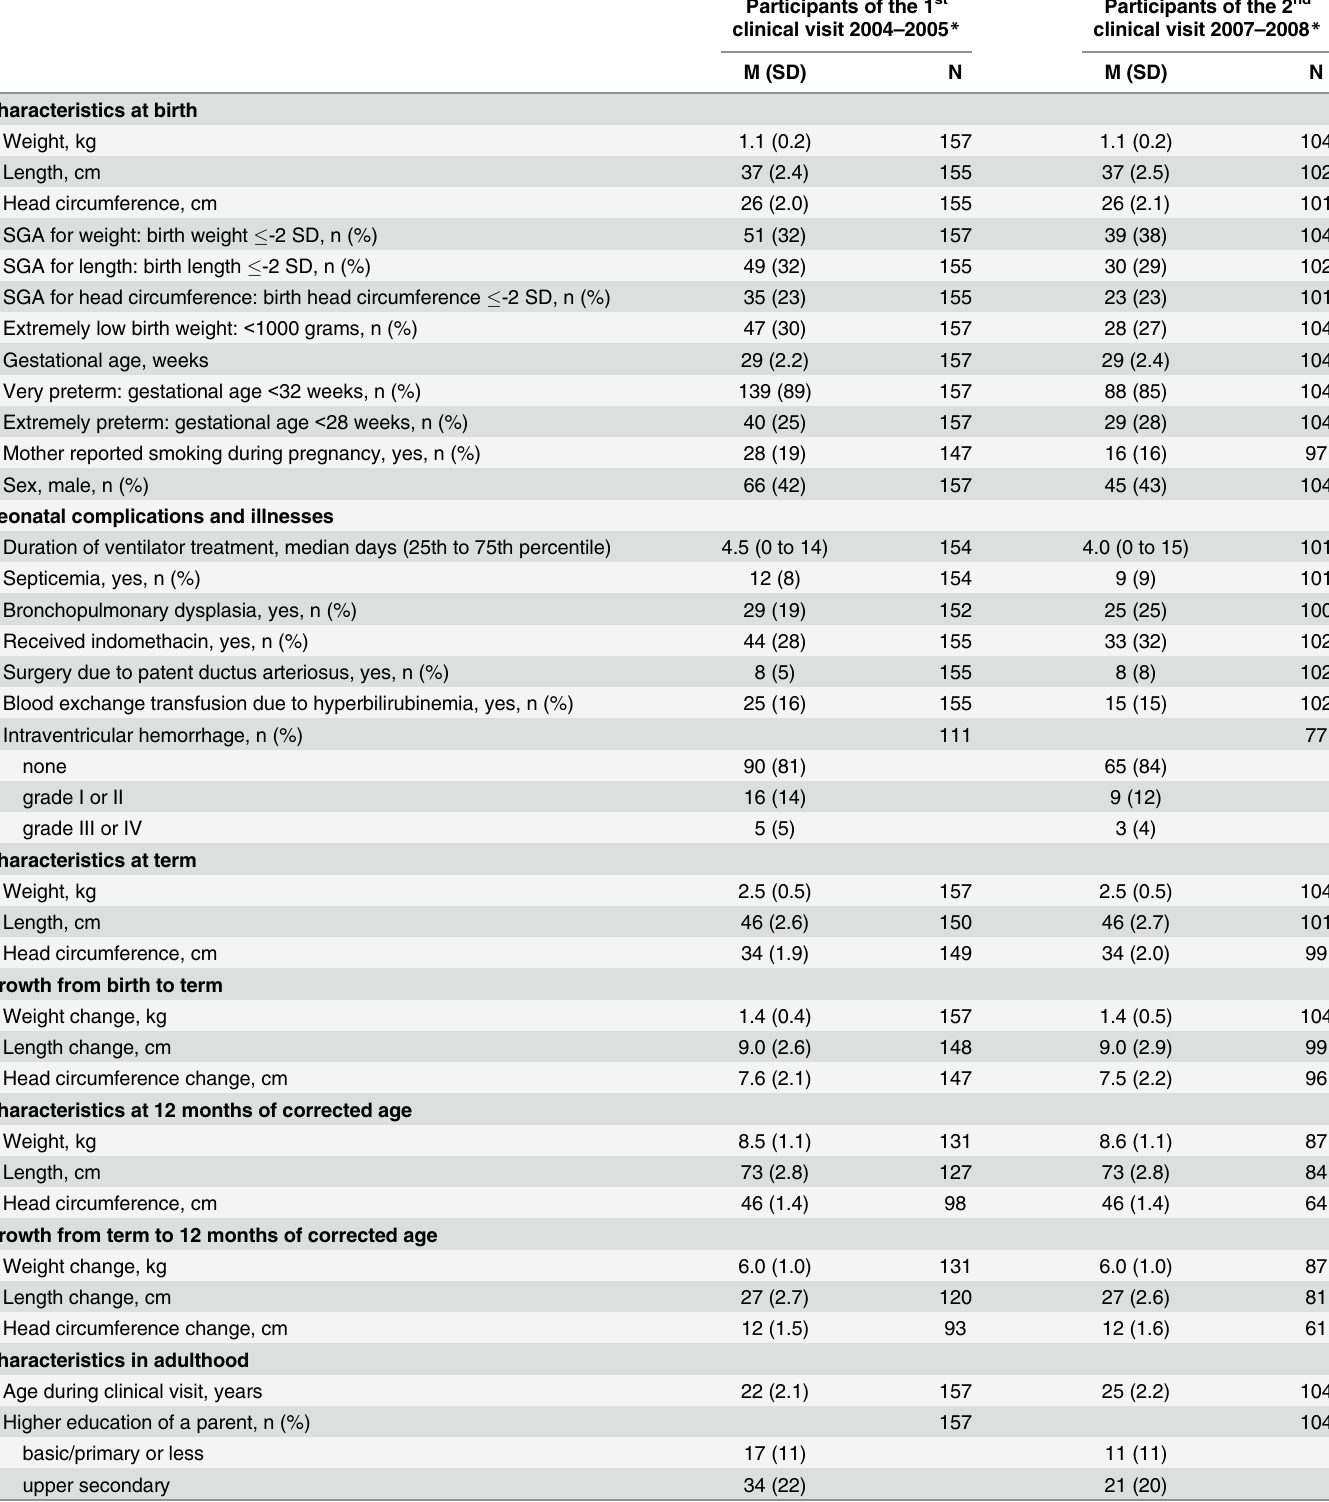
Table 1. Growth and infant and young adult characteristics of individuals born preterm at very low birth weight ( < 1500g).